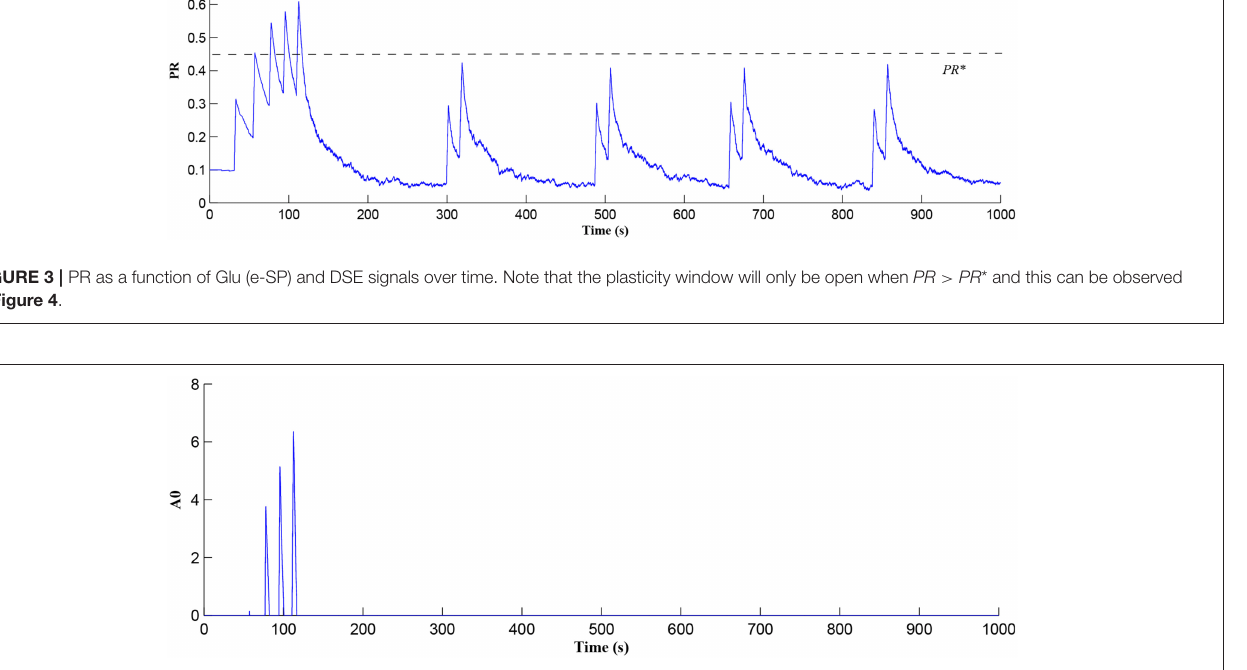
FIGURE 4 | Plasticity window height A 0 as a function of time. Note that PR acts as a switch to open/close the plasticity window controlling the learning